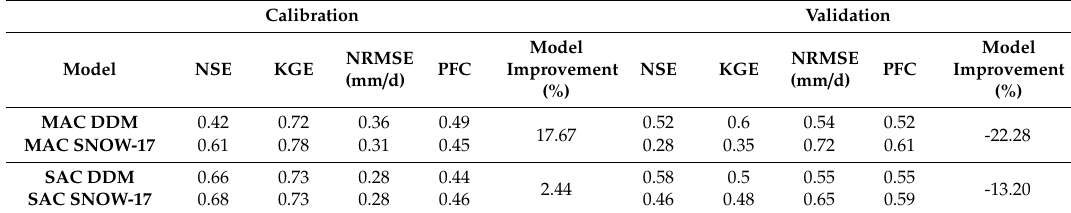
Table 6. Percentage of sub-basins performing better / competitive with a) DDM than SNOW-17 b) Seasonal than Annual model calibration and c) SAC-SMA than MAC-HBV model. Percentage of Percentage of Sub-Basins Percentage of Sub-Basins Sub-Basins Performing Performing Better / Comparable with Performing Better / Comparable with Better / Comparable with SEASONAL Models than ANNUAL SAC-SMA Than MAC-HBV DDM Than SNOW-17 Models Hydrologic Model